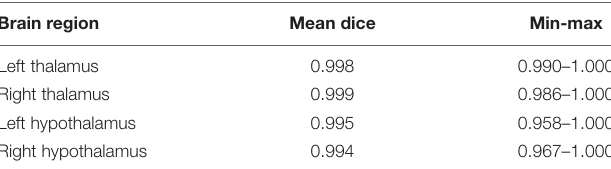
TABLE 5 | Validation of the automatic segmentations of thalamus and